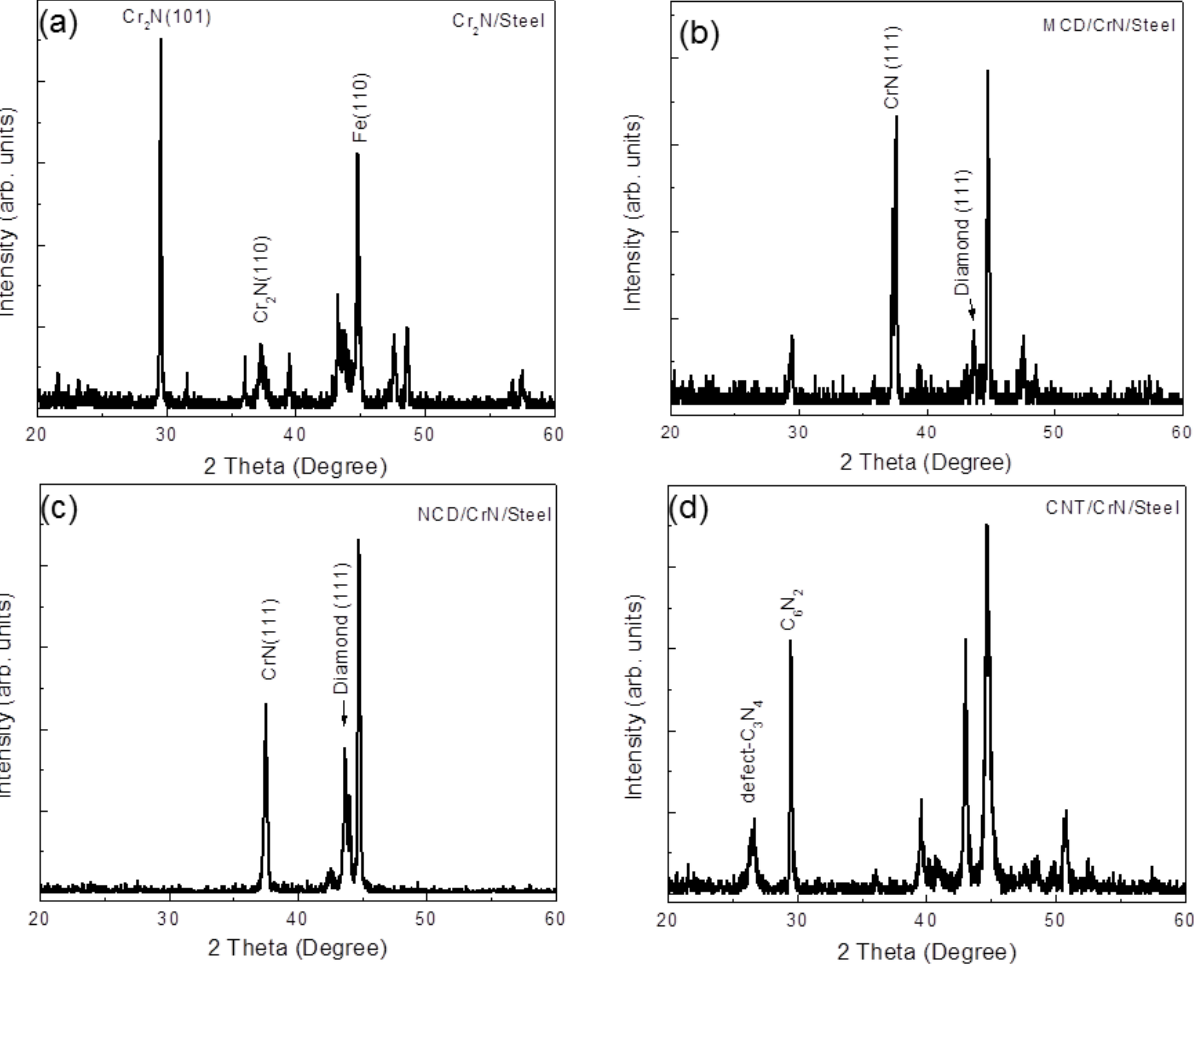
Figure 3. XRD of ( a ) CrN-coated steel substrate, ( b ) MCD/CrN/Steel, ( c ) NCD/CrN/Steel, and ( d )